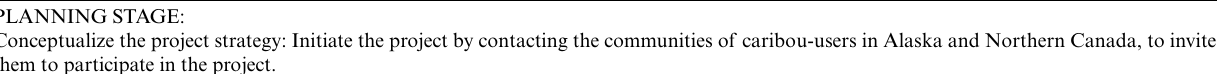
Table 2 . The main steps in the process and important tasks of each step, as identified by the Voices Project. PLANNING STAGE: Conceptualize the project strategy: Initiate the project by contacting the communities of caribou-users in Alaska and Northern Canada, to invite them to participate in the project.